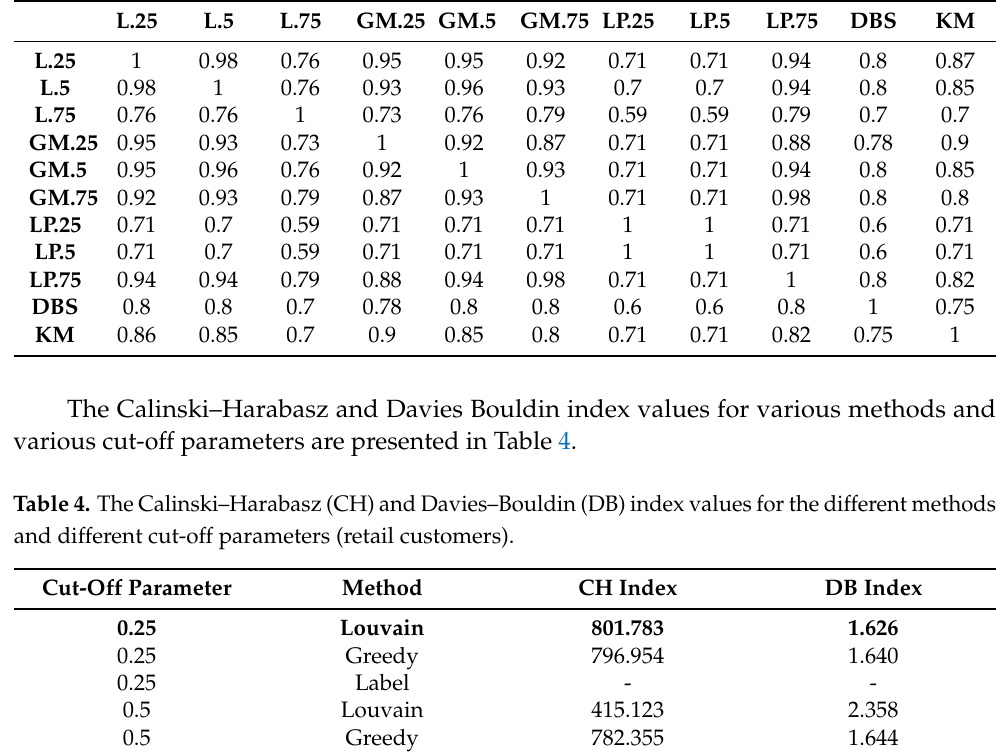
Table 3. FMI index for retail customers clustering.